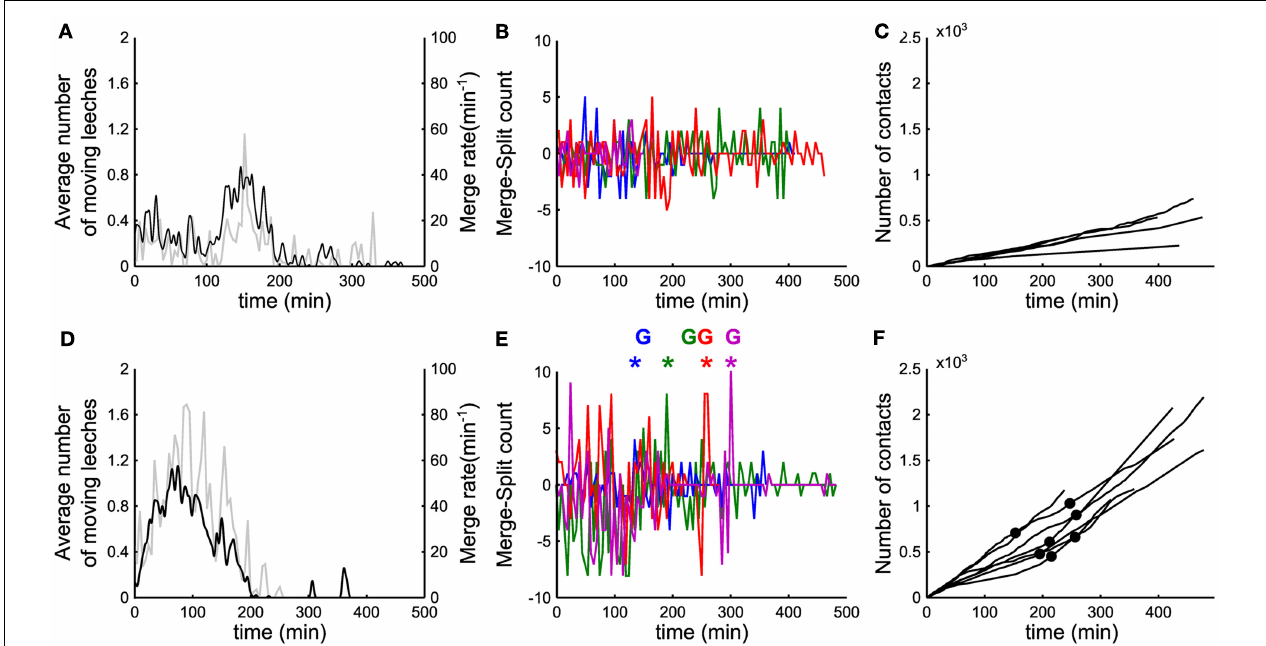
contacts per minute (cumulative sum). (A–C) Data for five leeches. (D–F) As in (A–C) but for 10 leeches. In (B,E) data from 4 experiments in different colors. In (E) , colored asterisks mark the occurrence of a peak of merges preceding the formation of a stable group, marked with the letter G (same color). In (F) , filled black dots mark the time instant in which a stable group